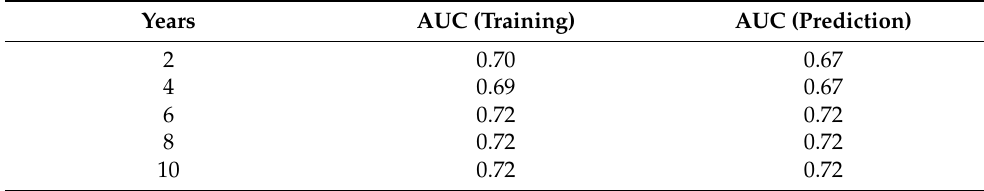
Table 7. Results of the validation of susceptibility models generated with training area 3, level 2 of COS2018 land use classification and different years of information on wildfire